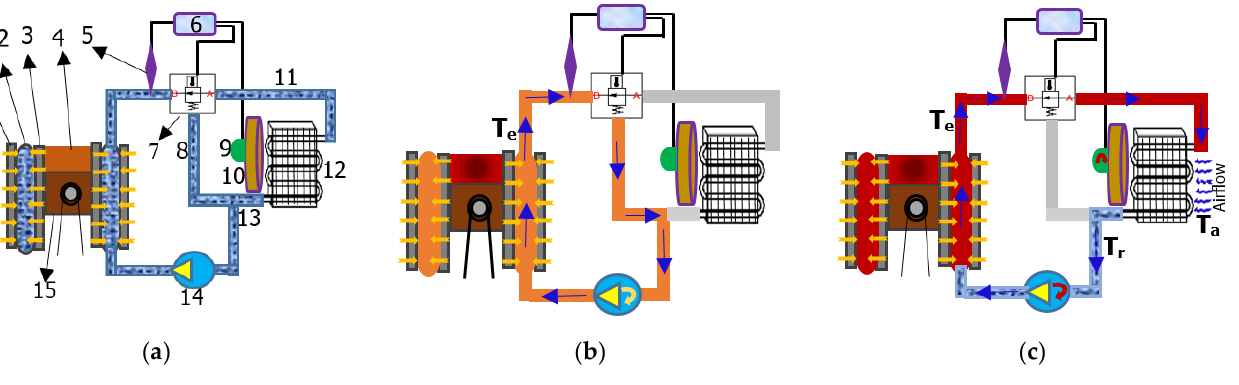
Figure 1. Active engine cooling system. ( a ) Simplified system architecture: (1) engine block, (2) cool- ing jacket, (3) cylinder wall, (4) combustion chamber, (5) temperature and pressure sensor, (6) cooling system control module, (7) SMA-based thermostat, (8) bypass hose, (9) electrical motor, (10) fan, (11) radiator upper hose, (12) radiator, (13) radiator lower hose, (14) coolant pump, and (15) piston. ( b ) System with closed thermostat (the blue arrows indicate the flow direction of the coolant in the system.). ( c ) System with open thermostat ( Ta: outside ambient air temperature, Te : engine coolant temperature, Tr: coolant temperature measure at radiator outlet hose).